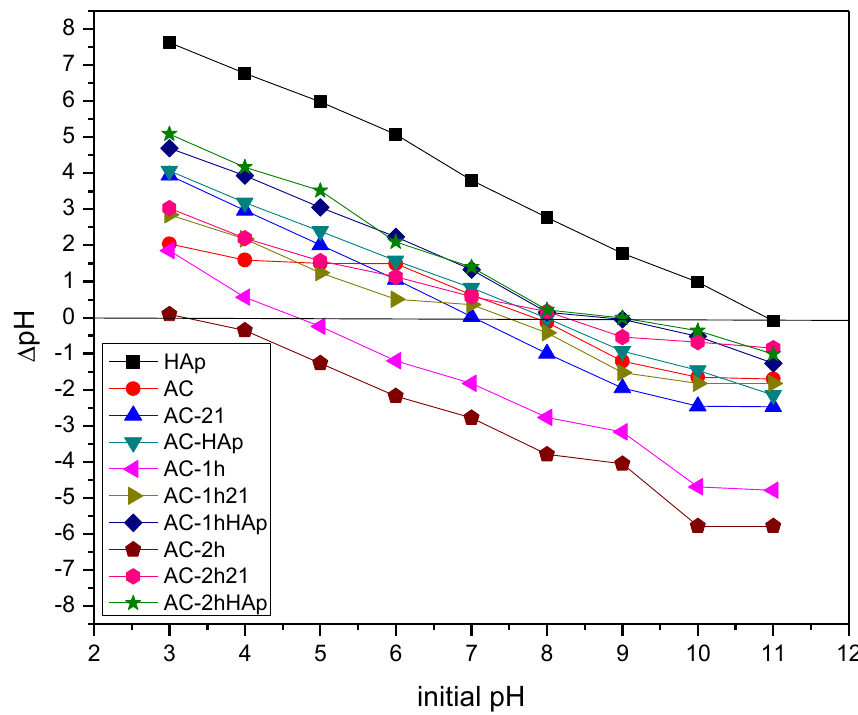
Figure 8. Charge distribution of the different materials.